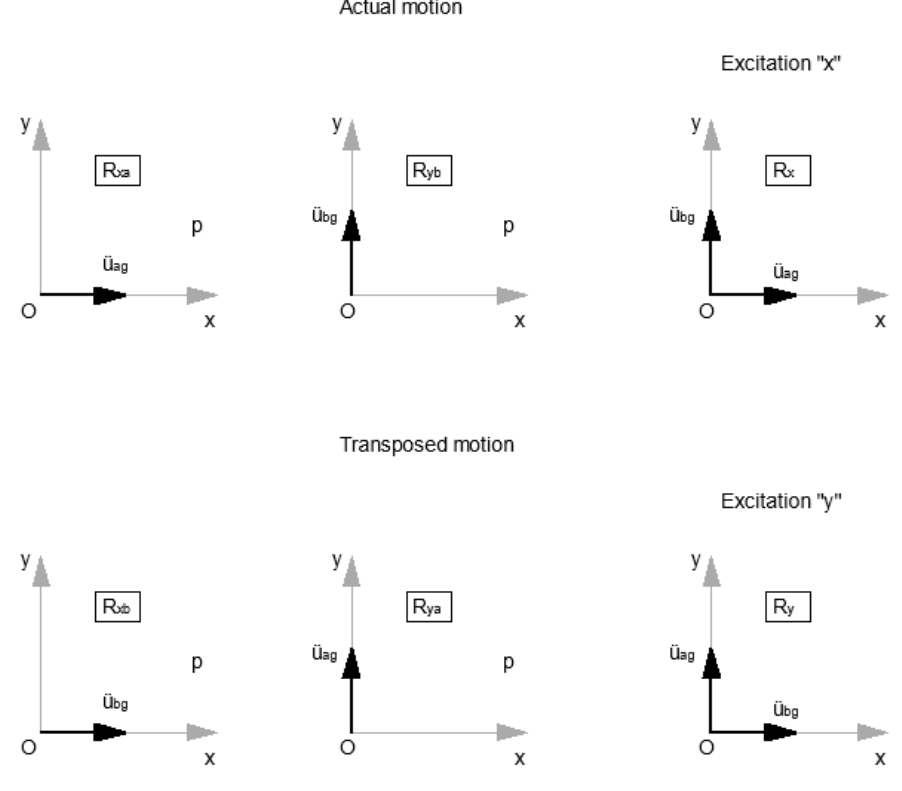
Figure 4. Displacements with respect to the reference axis ( x , y ) [26].